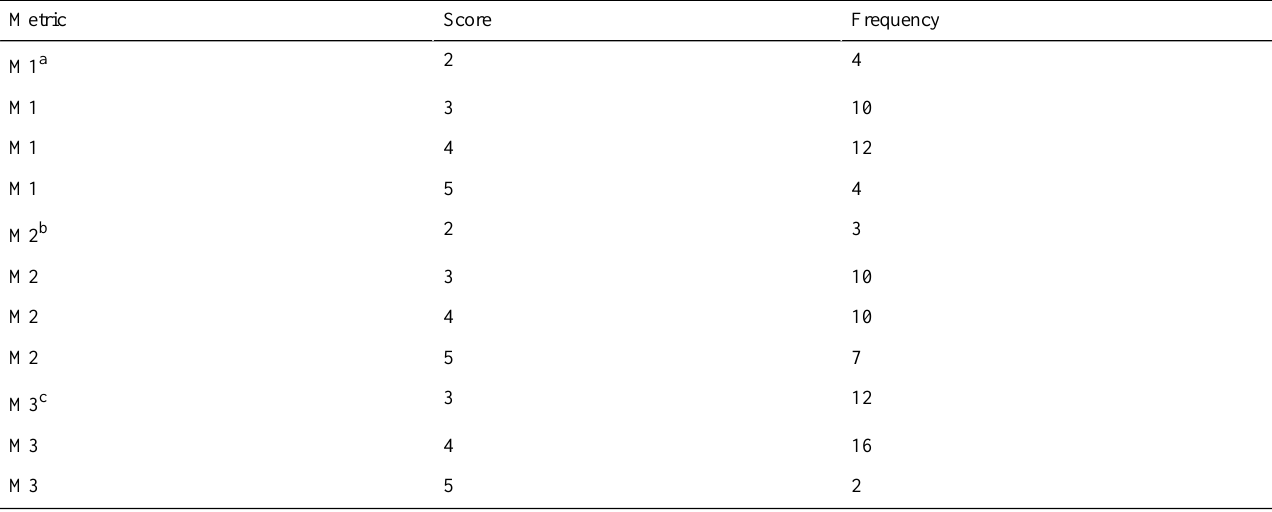
Table 11. Frequency distribution of scores with respect to each metric by all